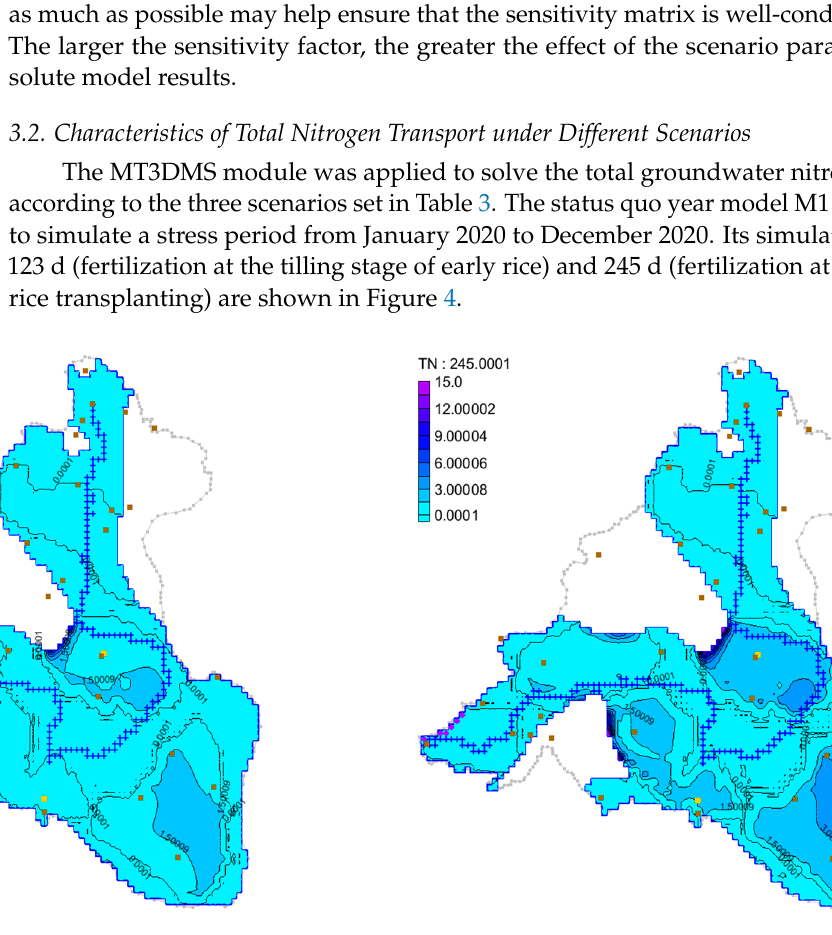
Figure 4. Total nitrogen simulation results at 123 d and 245 d of the current year model. Note: The blanks in the figure are karst solitary peaks/peak cluster depressions, and the aquifer is drained, so the model cannot display the simulation results.